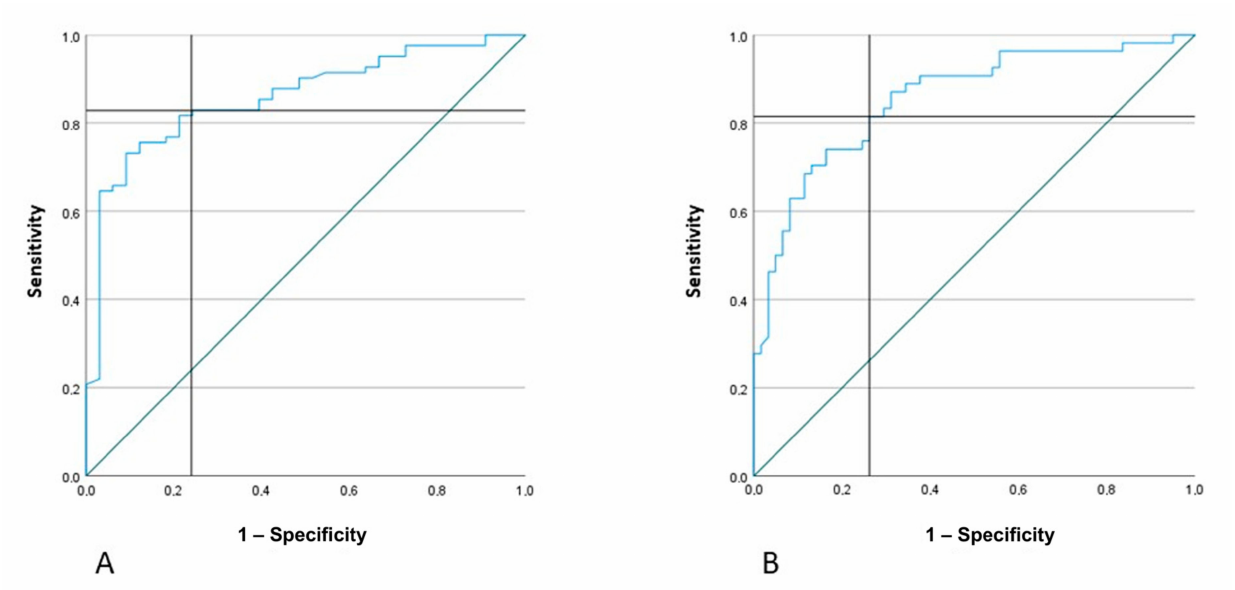
Figure 5. ROC curves to find the best AR cut-off values able to discriminate, respectively, NIHSS ≥ 5 ( A ) and NIHSS ≥ 10 ( B ). AR = Asymmetry Index, NIHSS = National Institutes of Health Stroke